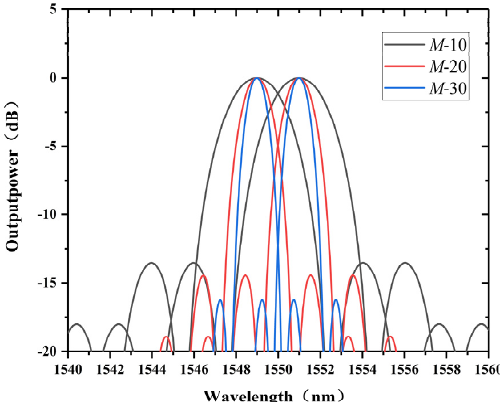
Figure 4. Transmission spectra of adjacent AWG channels under different diffraction orders (M).